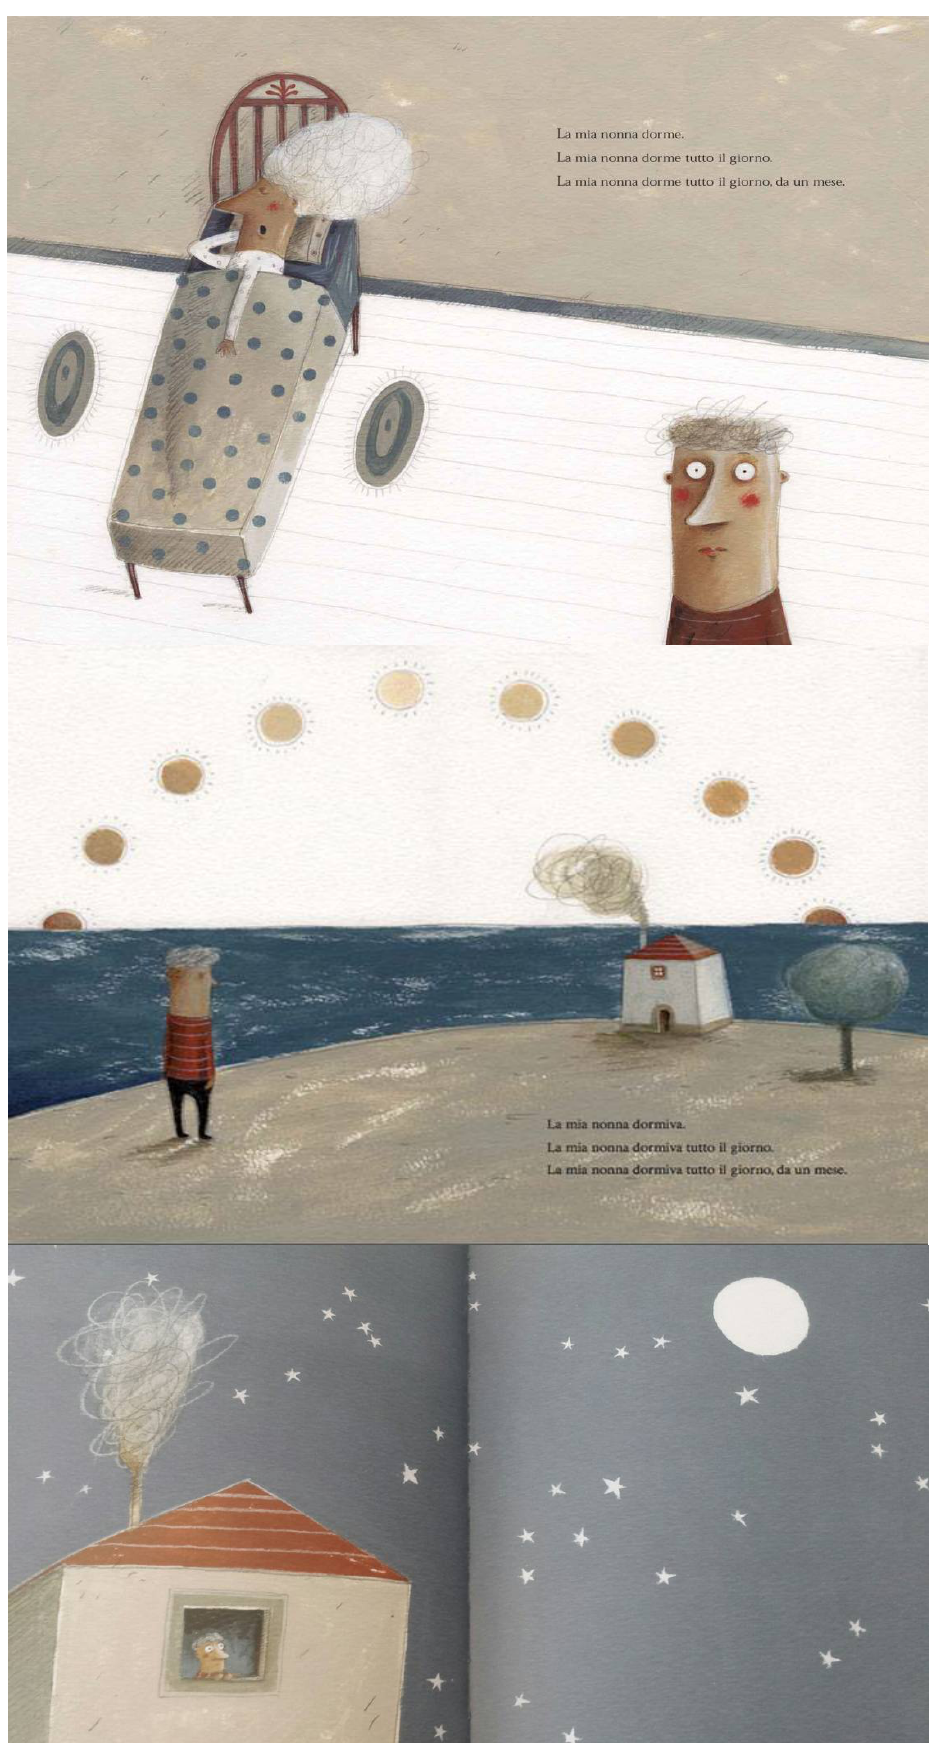
Figure A11. Parmeggiani, R. La nonna addormentata. ill. Vaz de Carvalho J. Firenze, Kalandraka,